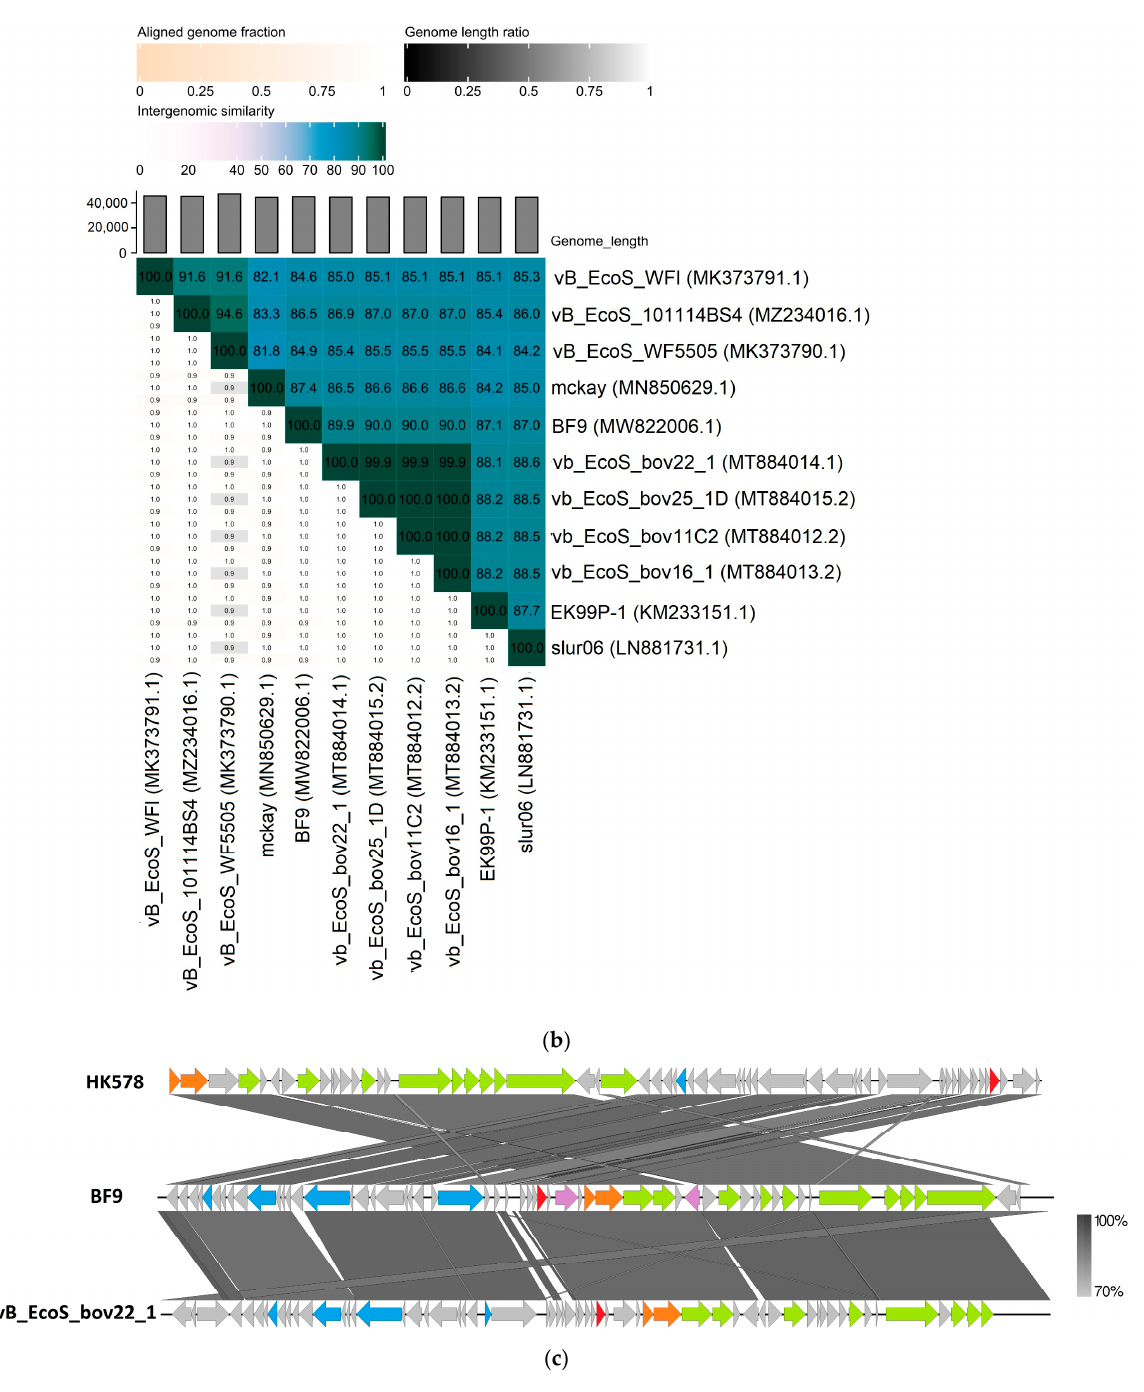
Figure 2. Genomic and phylogenetic analysis of bacteriophage BF9. ( a ) Phylogenetic tree of BF9 (in bold) generated by VICTOR using the whole-genome sequences of phage homologs in BLASTn. The numbers above branches are GBDP pseudo-bootstrap support values from 100 replications. ( b ) VIRIDIC heatmap based on intergenomic similarities between BF9 and closest homologs in BLASTn. The number in the chart represents the similarity percentage. ( c ) Genome comparison of BF9 with closely related members of the Dhillonvirus genus. The grey shading indicates sequence similarities between the genomes. The predicted functions of proteins are indicated by different colors: phage morphogenesis and virion structure (green arrows), DNA packaging (orange arrows), host lysis (red arrows), phage DNA replication and modification (blue arrows), and additional functions (purple arrows). Grey arrows represent ORFs of unknown